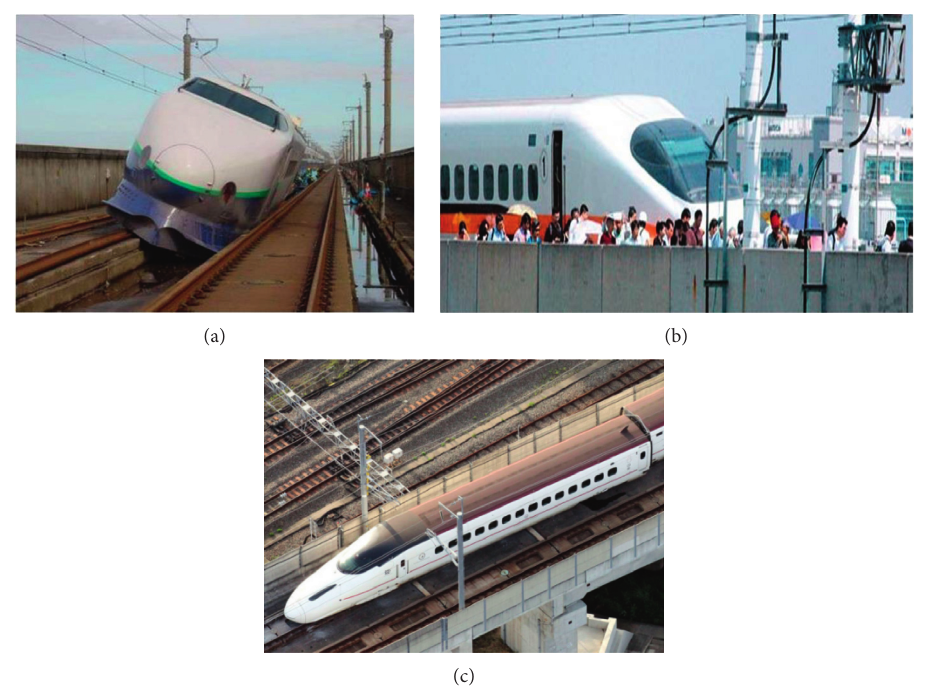
Figure 1: Derailment of HSR trains on bridges due to earthquakes. (a) Niigata Chuetsu earthquake in Japan. (b) Jiashian earthquake in Taiwan. (c) Kumamoto earthquake in